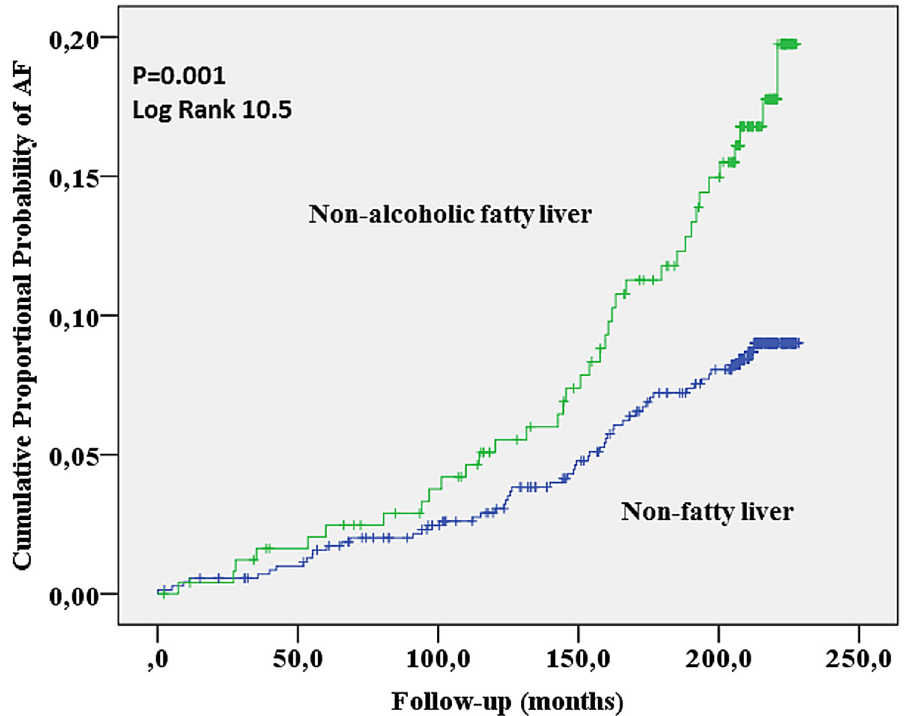
Fig 1. The cumulative proportional probability of AF in the NAFLD